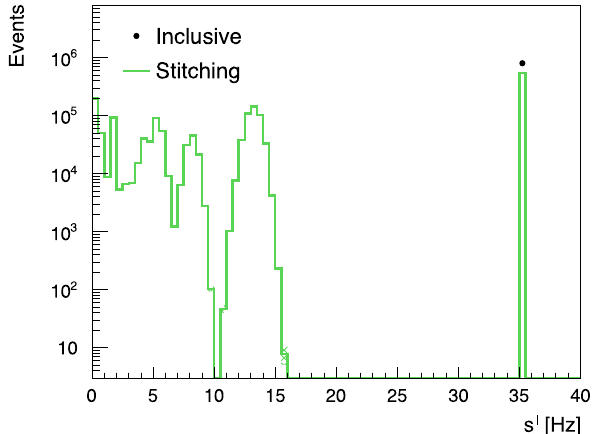
Fig. 4 Stitching weights s I , computed according to Eq. (11), for the inclusive sample and for the samples produced in ranges of ˆ p T